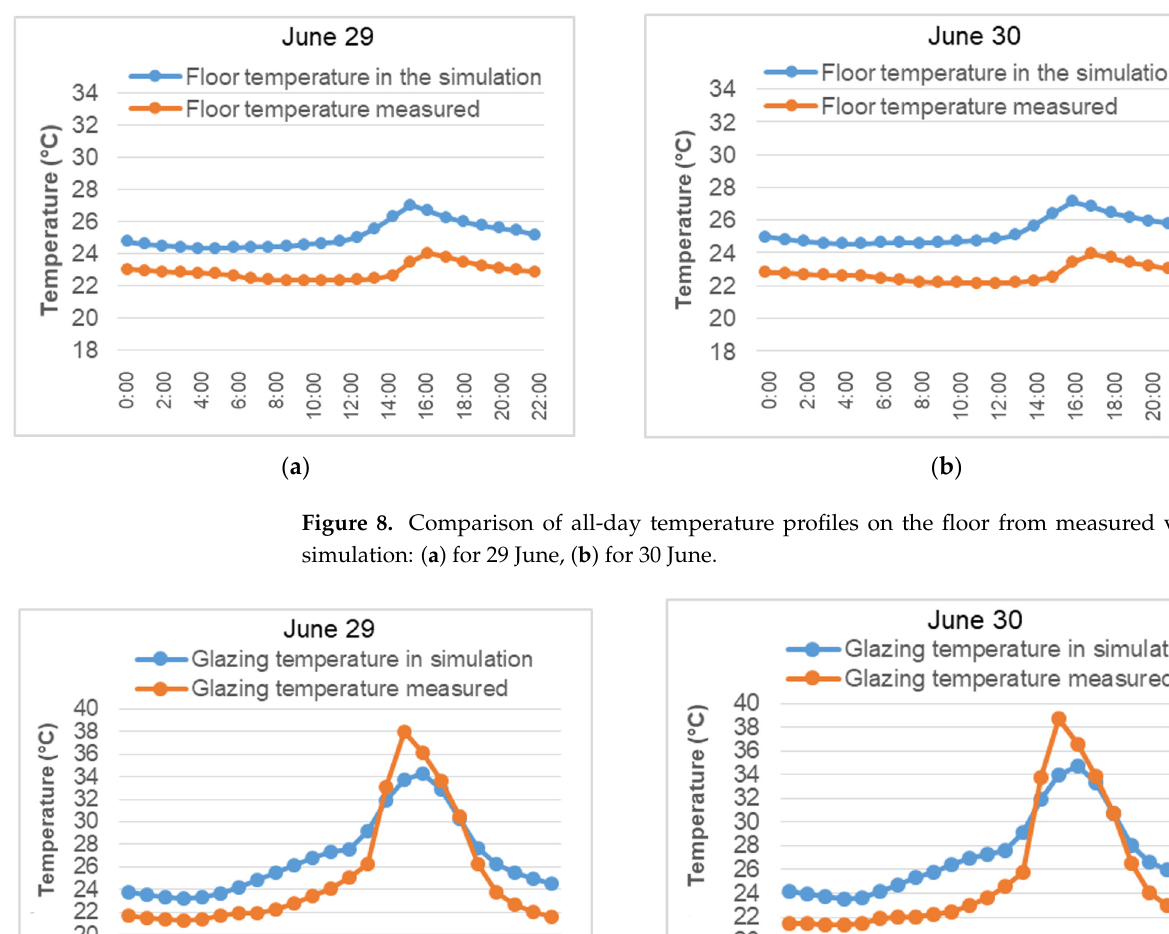
( b ) Figure 7. Comparison of the all-day course of internal temperatures from the measured values from the simulation: ( a ) for 29 June, ( b ) for 30 June. For the floor surface temperatures, there were some variations caused by the air tem- perature stratification over the room height. Figure 8 shows a comparison of floor tem- peratures from the simulation and from the measured values. It is again clear that the waveforms during 29.6. and 30.6. are identical, differing only in their maxima. On 29 June, we managed to reconcile the time when the measured value and the value of the simula-